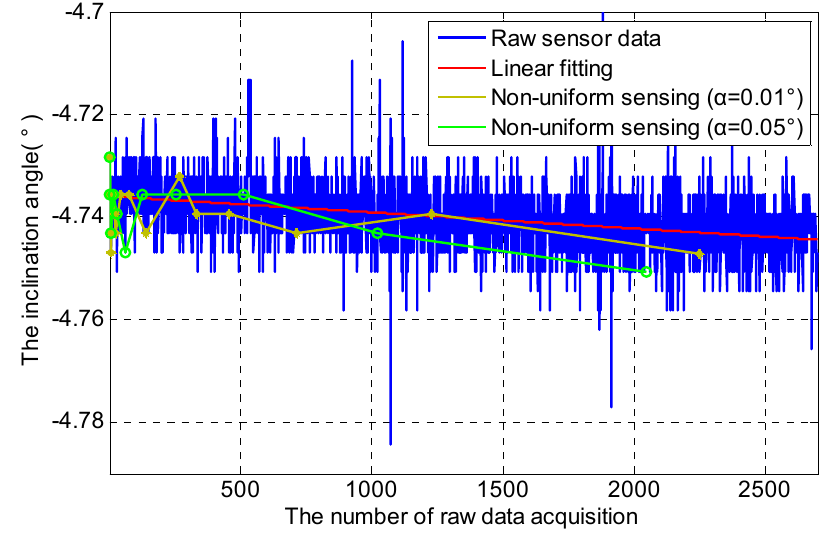
Figure 7. Non-uniform sensing with cooperative TDSS in Scenario B in a short-term span.